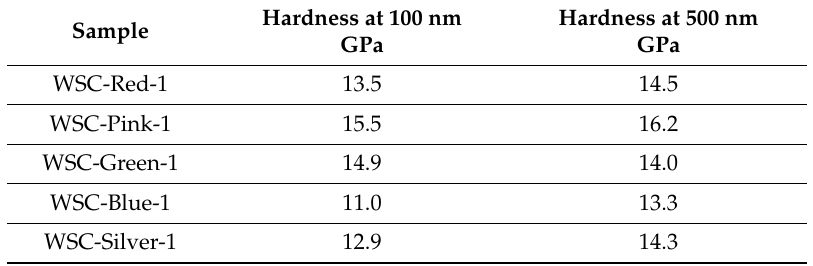
Figure 3. Measured nanoindentation hardness vs. indentation depth for Design Strategy 1 hard coatings. Variations in hardness are due to the thickness and the number of layers that are included in the design to achieve the targeted wavelength selectivity. Table 1. Summary of key mechanical properties for Design Strategy 1 hard coatings.